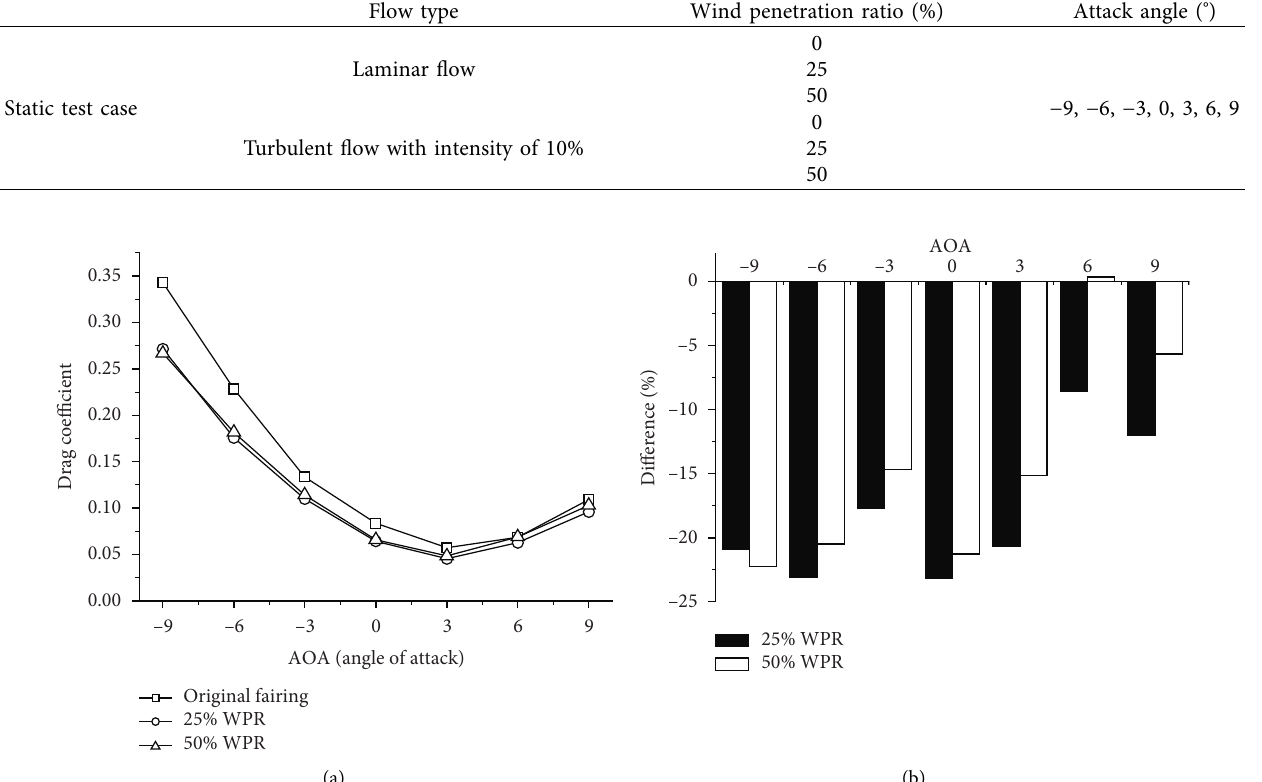
Figure 7: Static wind tunnel test results for C d (laminar flow): (a) C d versus AOA; (b) difference (%) versus AOA.